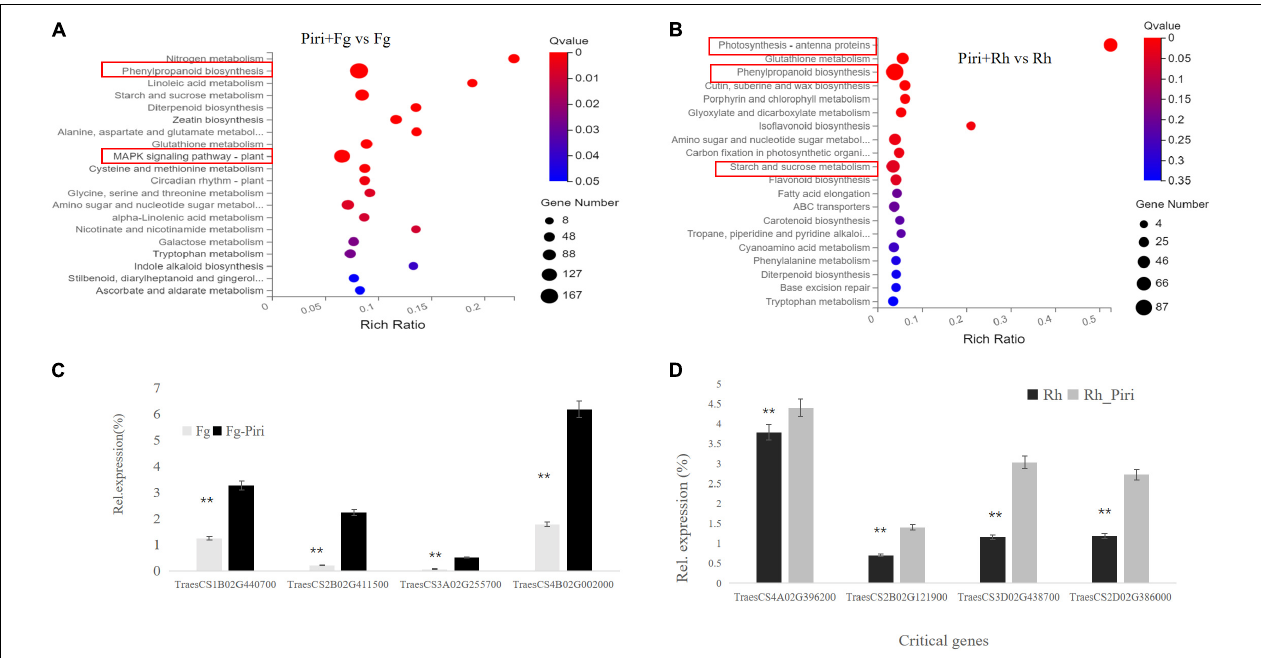
FIGURE 8 | Differentially expressed genes (DEGs) analysis in Kyoto Encyclopedia of Genes and Genomes (KEGG) pathway and QPCR identification by comparing Piri + Fg vs. Fg and Piri + Rh vs. Rh. (A) DEGs analysis in KEGG pathway by comparing Piri + Fg vs. Fg; (B) DEGs analysis in KEGG pathway by comparing Piri + Rh vs. Rh; (C) Identification of the critical genes by QPCR in Piri + Fg vs. Fg group; (D) Identification of the critical genes by QPCR in Piri + Rh vs. Rh group. Piri, P. indica ; Fg, F. graminearum ; Rh, R. cerealis ; Piri + Fg, P. indica + F. graminearum ; Piri + Rh, P. indica + R. cerealis.